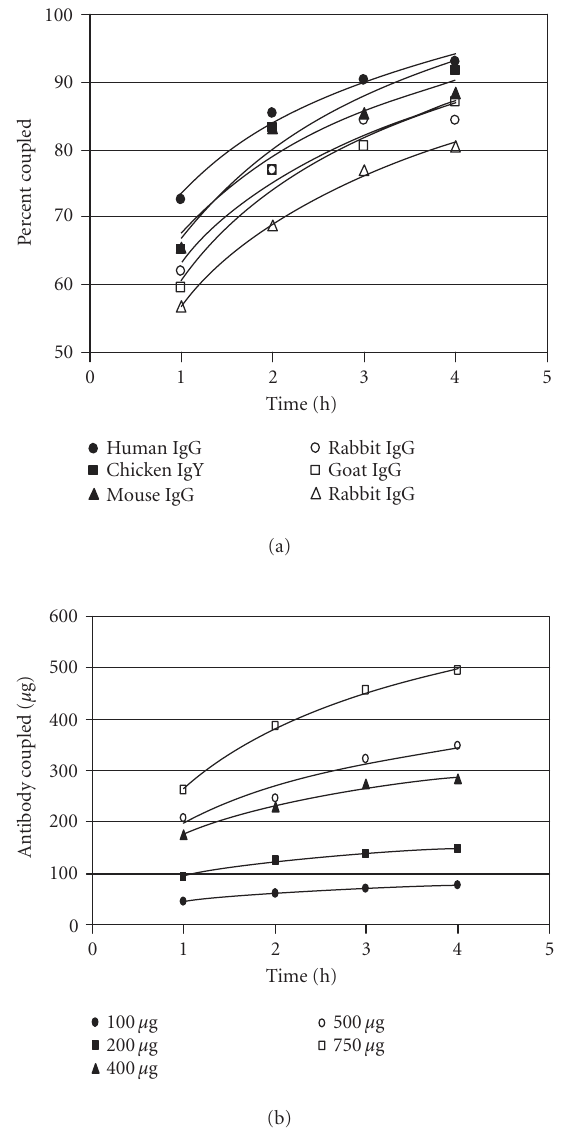
Figure 3. Coupling of mammalian and avian antibodies. (a) An- tibody from various species (200 µ g) was coupled to 200 µ L of coupling gel (settled gel) at 1-hour intervals for 4 hours at RT. For the chicken antibody, 500 µ L was used. (b) Normal chicken IgY antibody (100–750 µ g) was coupled to 200 µ L of coupling gel (settled gel) at 1-hour intervals for 4 hours at RT.